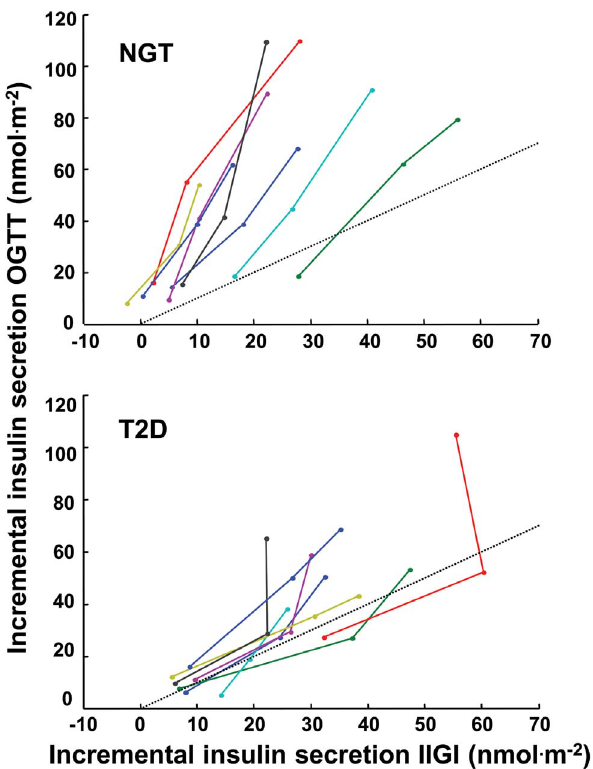
Figure 5. Incremental insulin secretion response to intravenous and oral glucose. Individual trajectories for the relationship between the dose-dependent increment above basal in total insulin secretion during the OGTT and the IIGI in NGT and T2D participants. The dotted lines are the identity line.